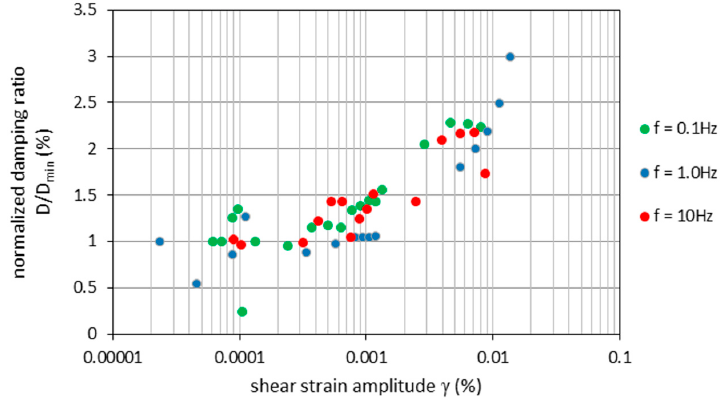
Figure 6. Normalized damping ratio D / D min versus shear strain amplitude for isotropically- consolidated RCA ( σ 3 ’ = 45 kPa) for various test frequencies.